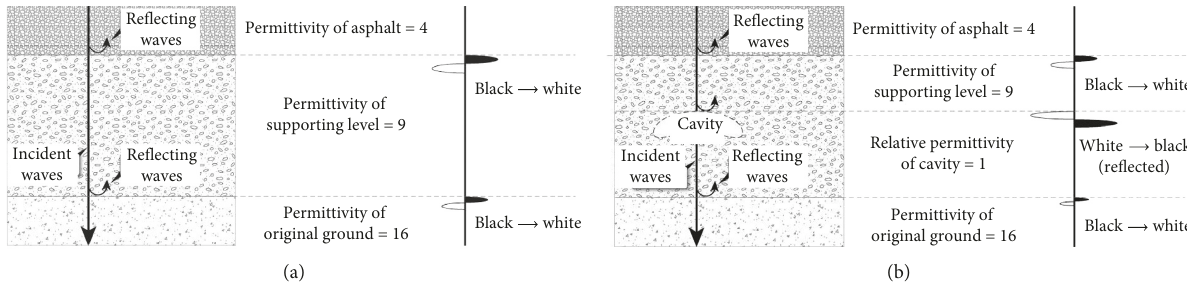
Figure 5: Reflected status of the polarity of the reflected wave. (a) In medium of homogeneous typical strata. (b) In cavity.